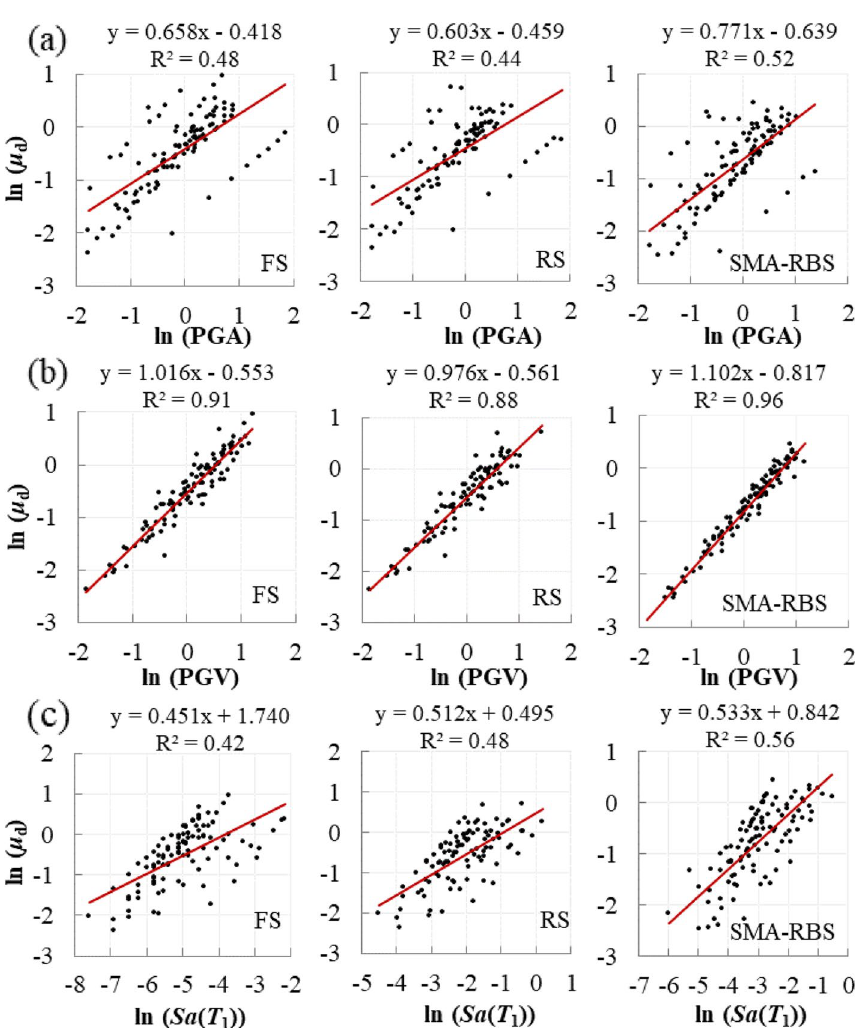
Fig. 9 Probabilistic seismic demand models (PSDM) for displacement ductility of pier considering different IM candidates ( a ) PGA, ( b ) PGV, and ( c ) Sa ( T 1 )